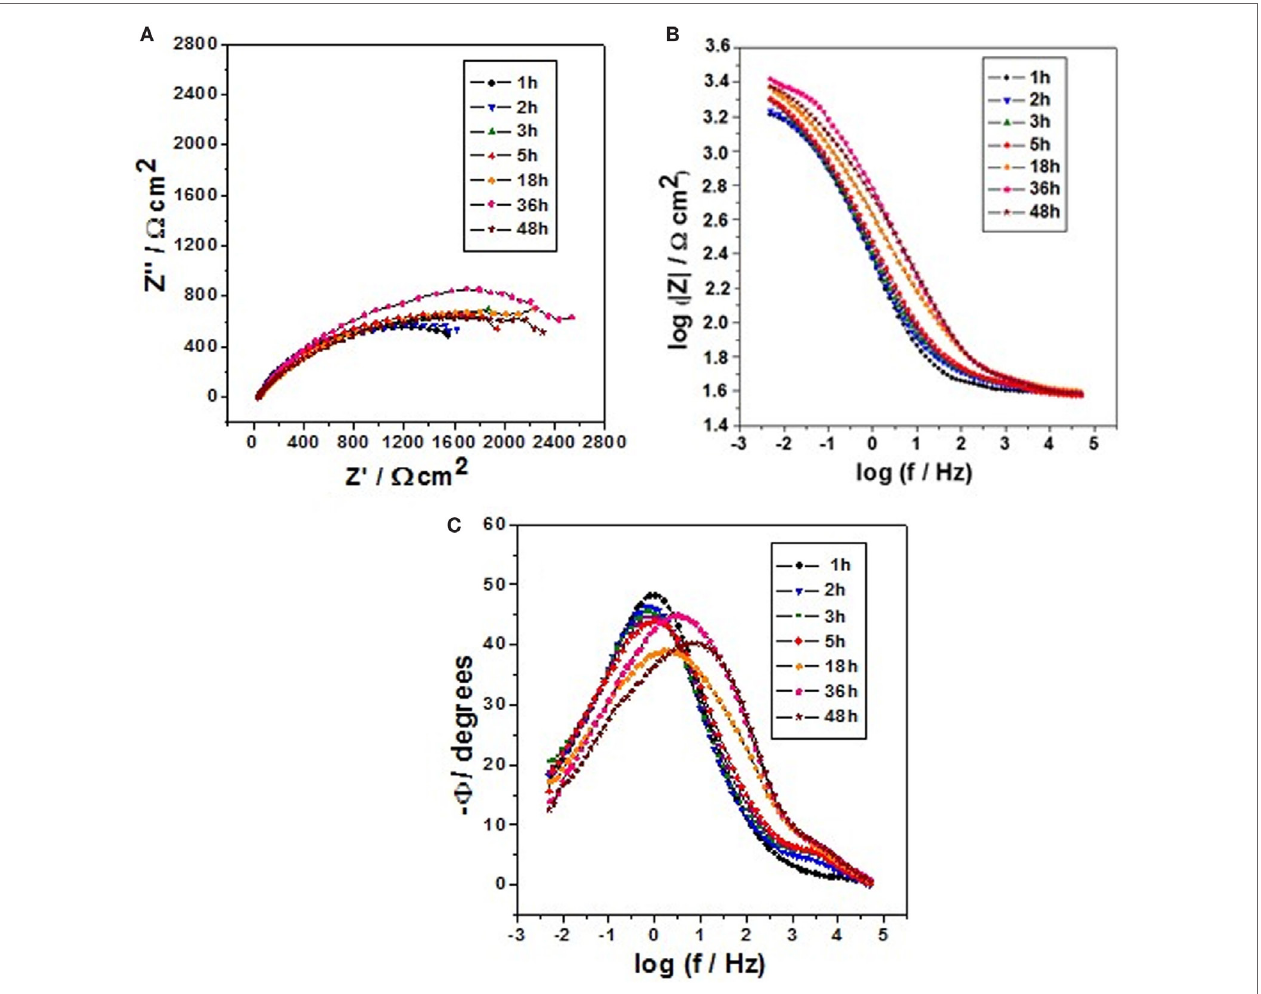
FigUre 4 | impedance diagrams: nyquist (a) and Bode (B,c) plots for carbon steel after different immersion times in 0.1 mol/l nacl at ph 6.2 and containing 1 wt.% of halloysite nanotubes with encapsulated dodecylamine